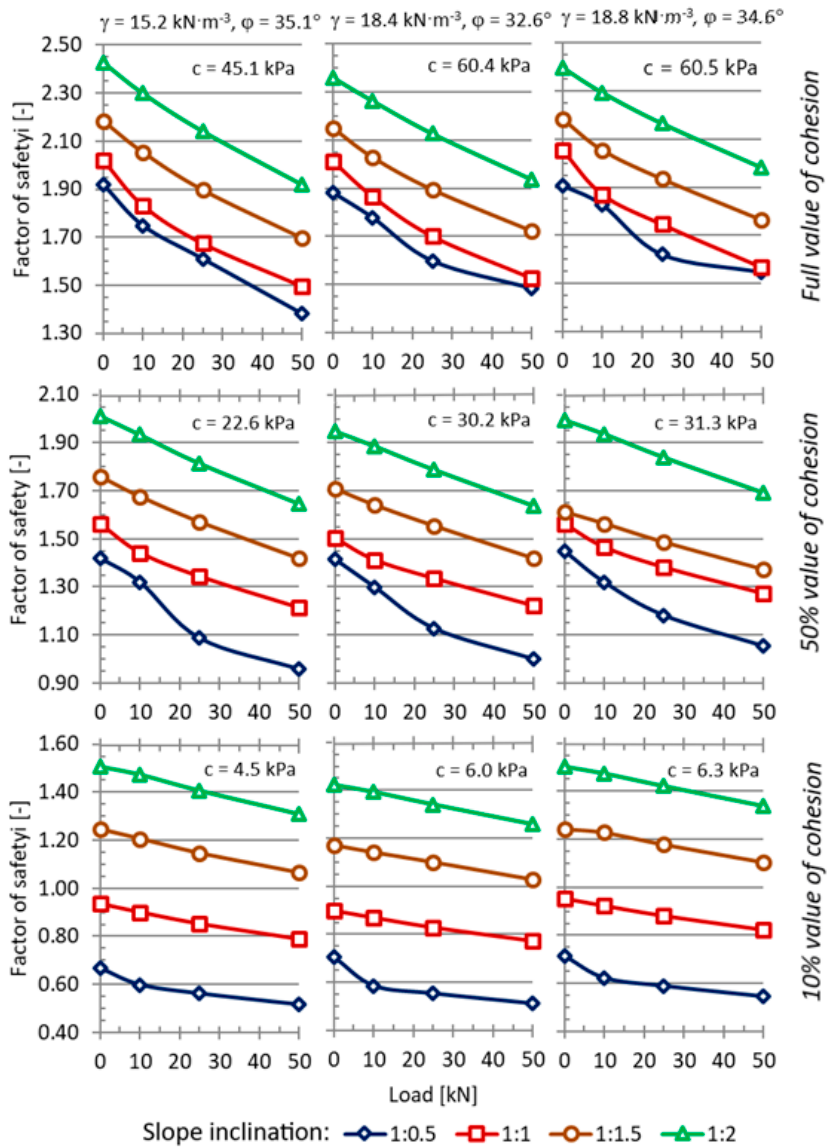
Figure 9. Changes in the factor of safety with increasing load on the embankment depending on the inclination.